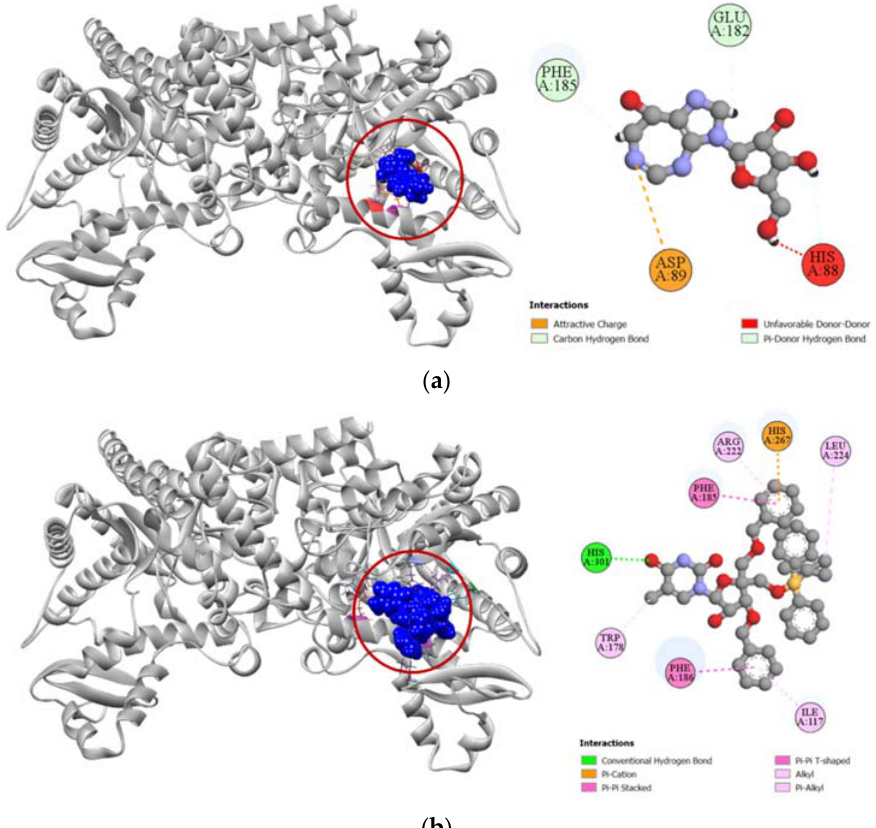
Figure 10. Pictorial representation (2D and 3D) of docking results for best-ranked pose of key interactions of ligands with the binding pocket of human adenosine deaminase 2 (PDB: 3LGG). ( a ) Coformycin with 3LGG; ( b ) compound 6 with 3LGG.